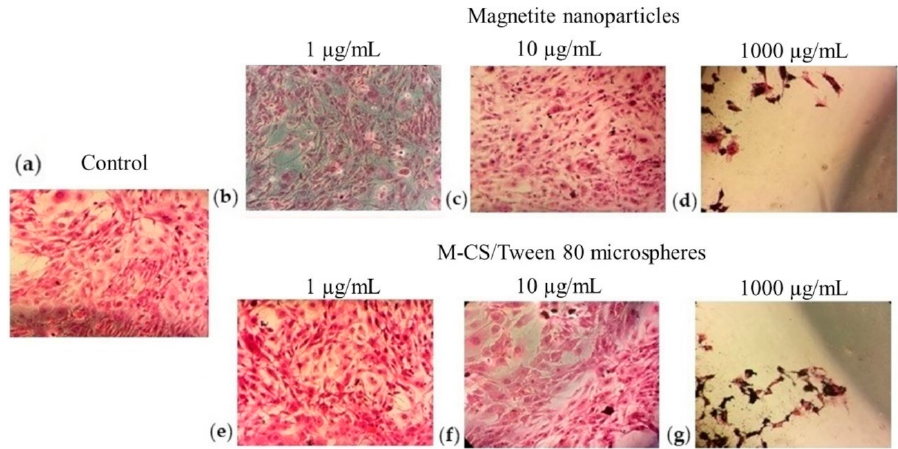
Figure 8. Optical microscope images of 40 × of H&E staining at 24 h. ( a ) Negative control with no particles; ( b – d ) Magnetite nanoparticles and ( e – g ) M-CS/Tween 80 microspheres at different